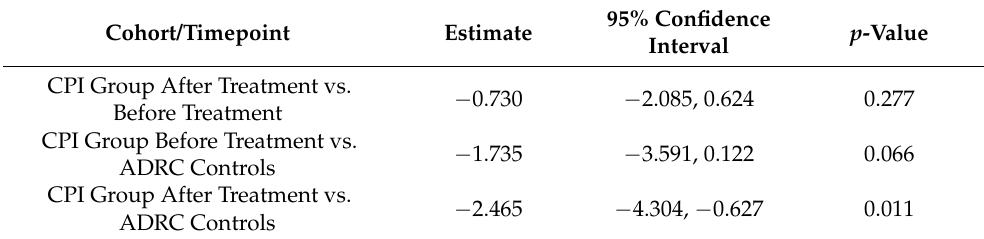
Table 8. Estimates for differences in MOCA-Blind